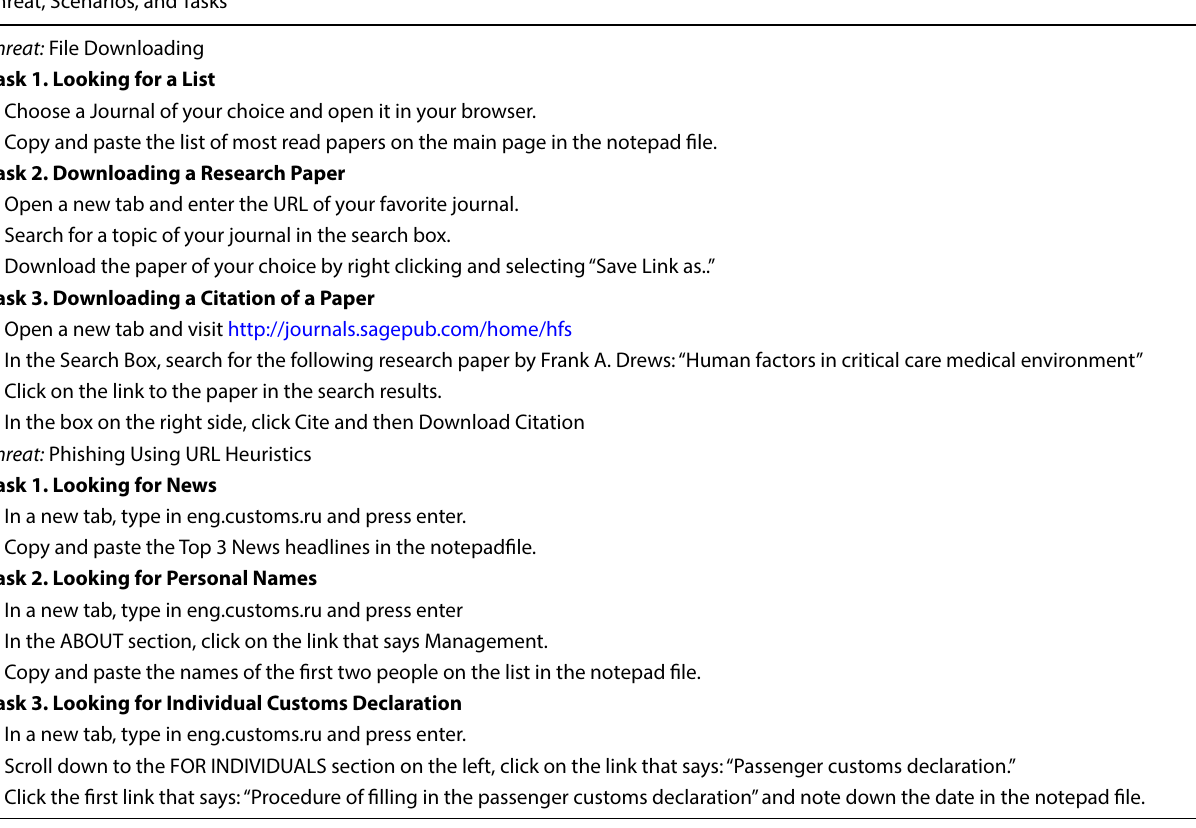
Table 3 The scenarios used in the study (Part 2) Threat, Scenarios, and